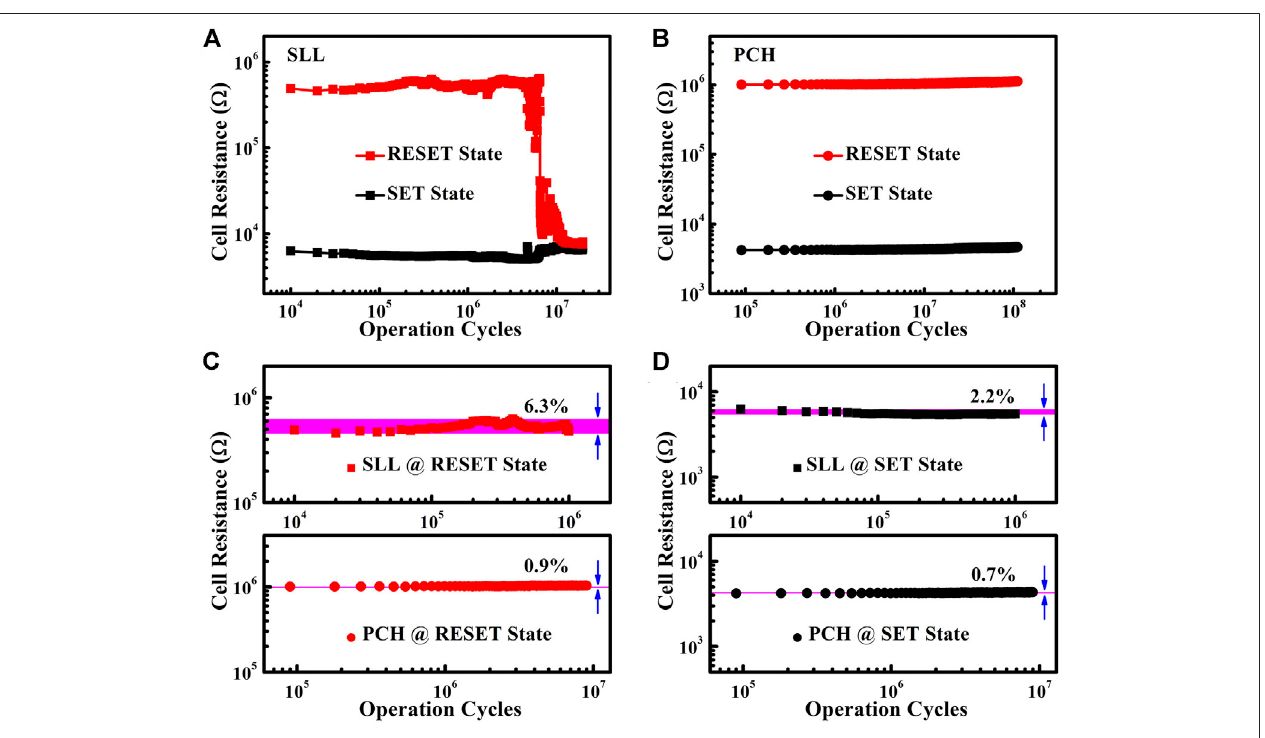
FIGURE 4 | (A) Approximately ∼ 10 7 cycling endurance of the SLL-based PCRAM device that fi nally failed due to SET stuck: SET (under 2.1 V) and RESET (under 3.2 V) with 20 ns width voltage pulses. (B) Approximately ∼ 10 8 cycles of the PCH device without failure under 10 ns width SET (1.6 V) and RESET (2.4 V) operations voltage pulses. (C) Comparison of the RESET resistance fl uctuations between the SLL- and PCH-based device, with the RSD being 6.3 and 0.9%, respectively. (D) Comparison of the SET resistance fl uctuations between the SLL- and PCH-based device, with the RSD being 2.2 and 0.7%,